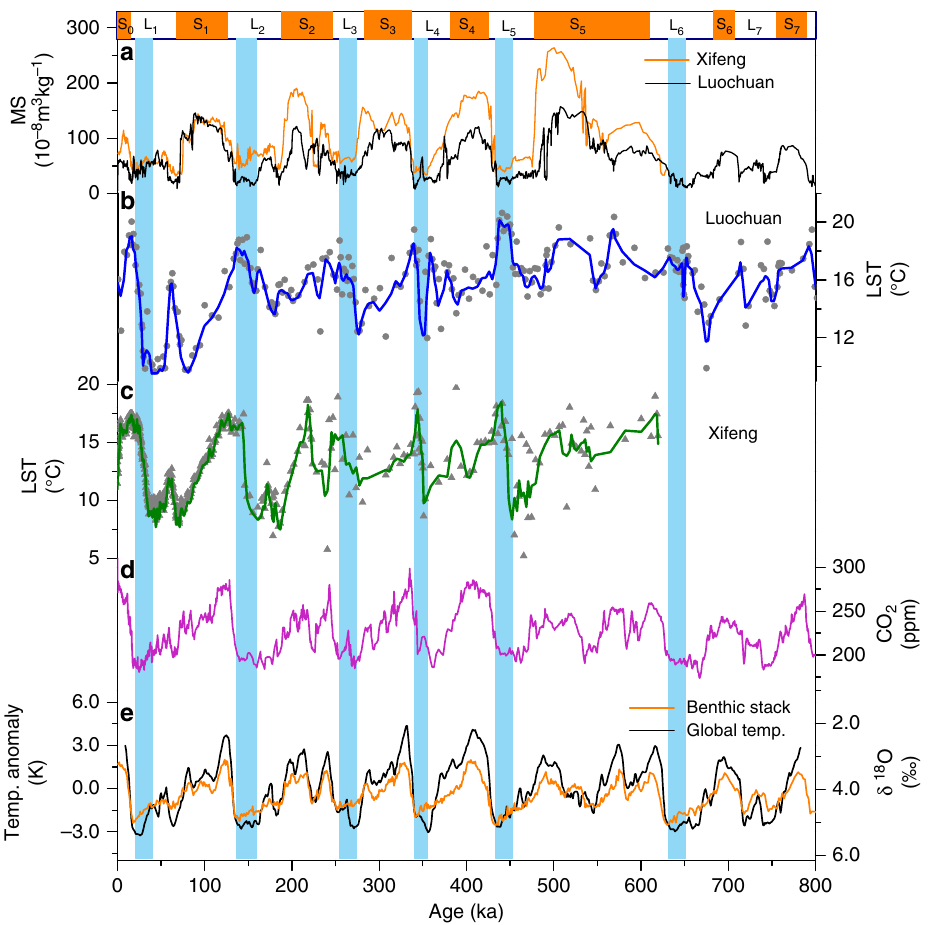
Fig. 3 800-kyr land surface temperature (LST) records from Luochuan and Xifeng sections on the Chinese Loess Plateau, compared with onsite magnetic susceptibility and global/marine indicators. a Luochuan and Xifeng magnetic susceptibility (MS) records with major loess (L 1 – L 7 ) and paleosol (S 0 – S 7, orange bars) units labeled. b , c LSTs from Luochuan and Xifeng, respectively, with their three-point moving averages. d Atmospheric CO 2 from Antarctic ice core records 24 . e Reconstructed global sea surface temperatures 19 and benthic δ 18 O stack 2 . The blue bars highlight intervals of early warming at Xifeng and Luochuan within glacial periods as indicated by other records. Initiation of LST rise led other indicators by ~7 – 20